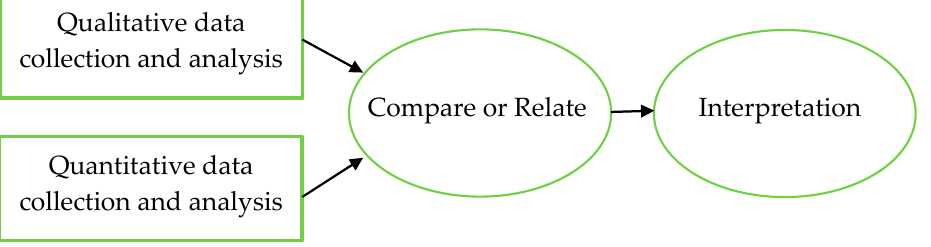
Figure 1. The convergent parallel mixed-methods approach.